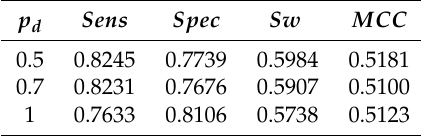
Table 4. Performance with different p d .